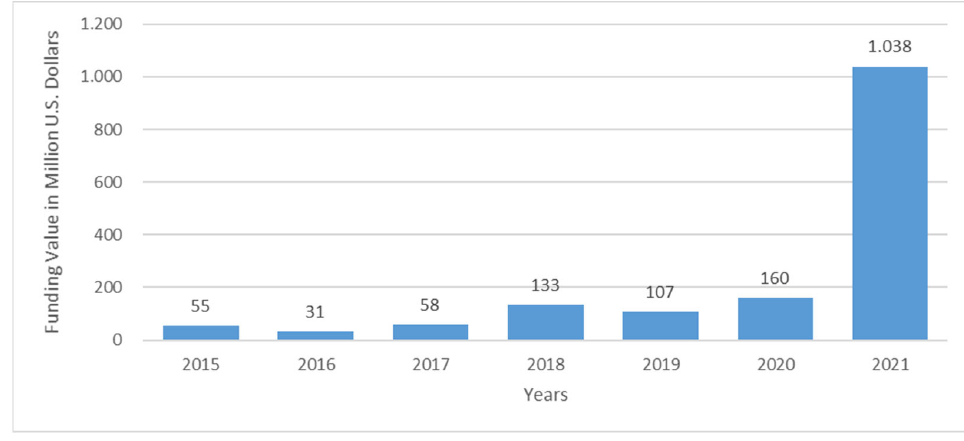
Figure 4. Funding secured by FinTech start ‐ ups in Africa from 2015 to 2021. Source: Statista, https://www.statista.com/statistics/1249965/african ‐ fintech ‐ startups ‐ funding/, (accessed on 10 August 2022).